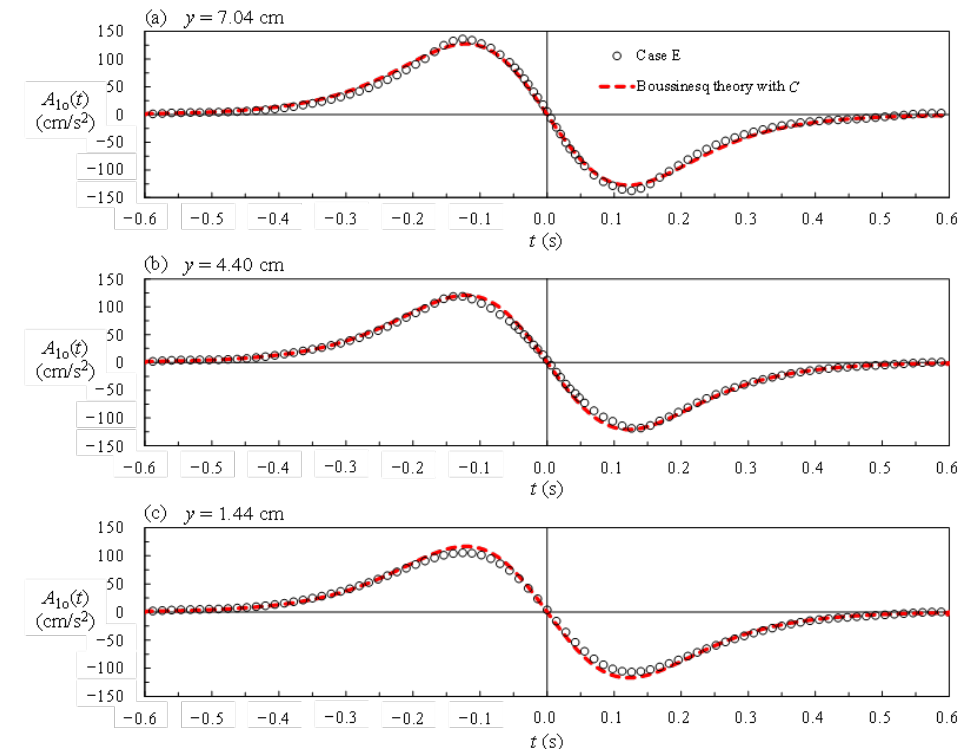
Figure 5. Time series comparisons of horizontal velocity between measured and predicted using Boussinesq solution (Case E) at y = ( a ) 7.04 cm; ( b ) 4.40 cm; and ( c ) 1.44 cm.